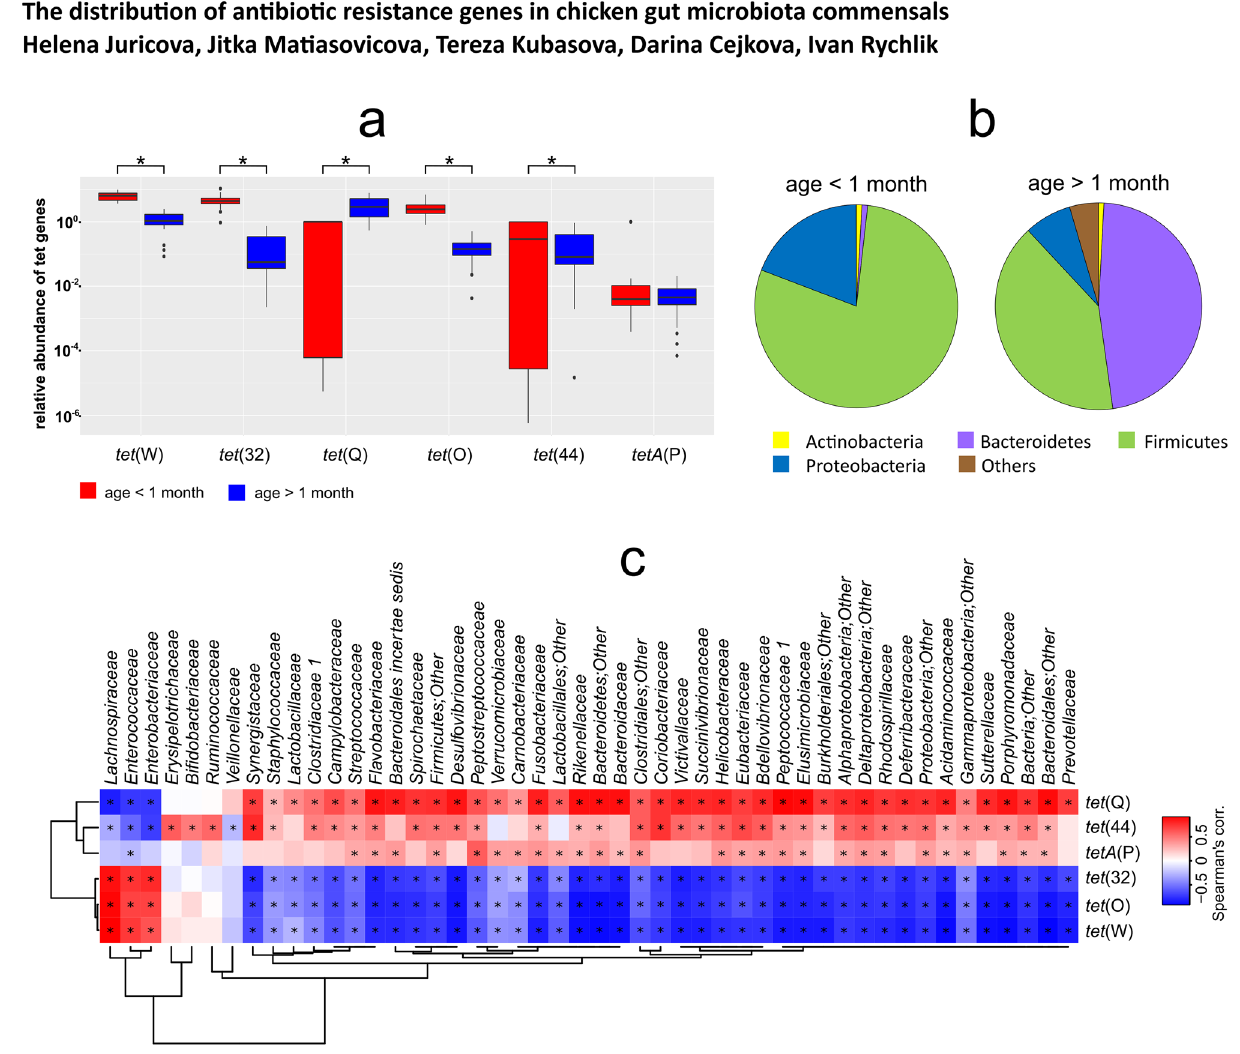
Figure 3. ( a ) Abundance of selected tetracycline resistance genes and ( b ) microbiota composition in chickens younger or older than 1 month. *, p < 0.05. In agreement with predictions from genomic analysis (Table 1 and Fig. 2), microbiota of chickens under 1 month of age was dominated by Firmicutes and tet genes characteristic for Firmicutes were commonly detected in these samples. On the other hand, Bacteroidetes formed approx. 47% of total microbiota of adult hens and tet (Q) gene, predicted as associated with Bacteroidetes , was significantly more abundant in the samples from adult chickens in comparison with the chickens younger than 1 month. ( c ) Correlation heat map of microbiota composition at family level and frequency of selected genes coding for tetracycline resistance. *, p < 0.05. The heat map was produced in R v4.0.2, https ://www.R-proje ct.org/ 18